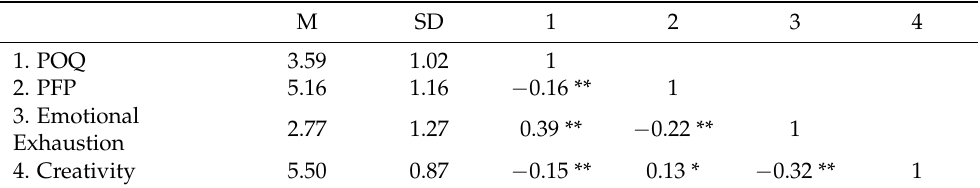
Table 4. Means, standard deviations, reliabilities, and correlations among study variables.